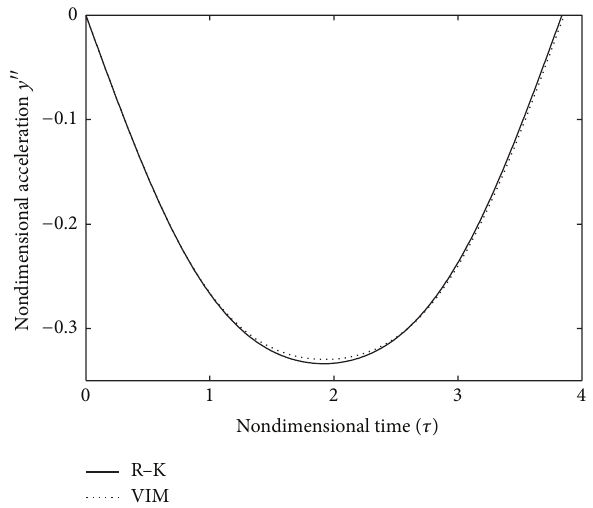
Figure 2: Comparison of the nondimensional acceleration 𝑦 󸀠󸀠 -time 𝜏 response of the system by the VIM with the one by the R-K method when the suspension angle 𝜙 0 = 60 ∘